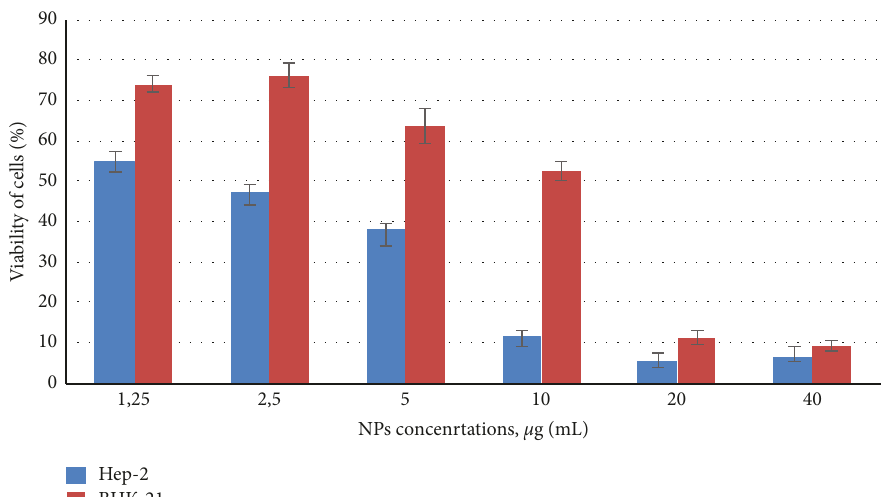
Figure 1: Influence of colloidal-coated silver on viability and mitochondrial activity of cells. Ofr -2 and BHK-21 cells growth curves after 72h exposure with NPs were monitored by colorimetric MTT assay. Control untreated cells − 100% viability. Values represent the mean ± S.D. for three independent experiments. Statistically significant difference between the growth inhibition effect was p < 0 . 05.